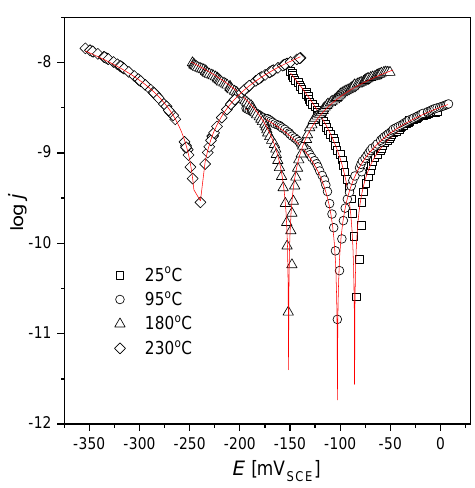
Figure 2. Polarization curves for the AISI 1010 steel electrodes immersed in sulfolane at 25, 95, 180, and 230 ◦ C; symbols—experimental data, solid lines—fit of the Equation (2); V SCE is the electrode potential measured versus saturated calomel electrode. Table 2. Electrochemical parameters for the AISI 1010 steel electrodes immersed in sulfolane at 25, 95, 180, and 230 ◦ C; V SCE is the electrode potential measured versus saturated calomel electrode.